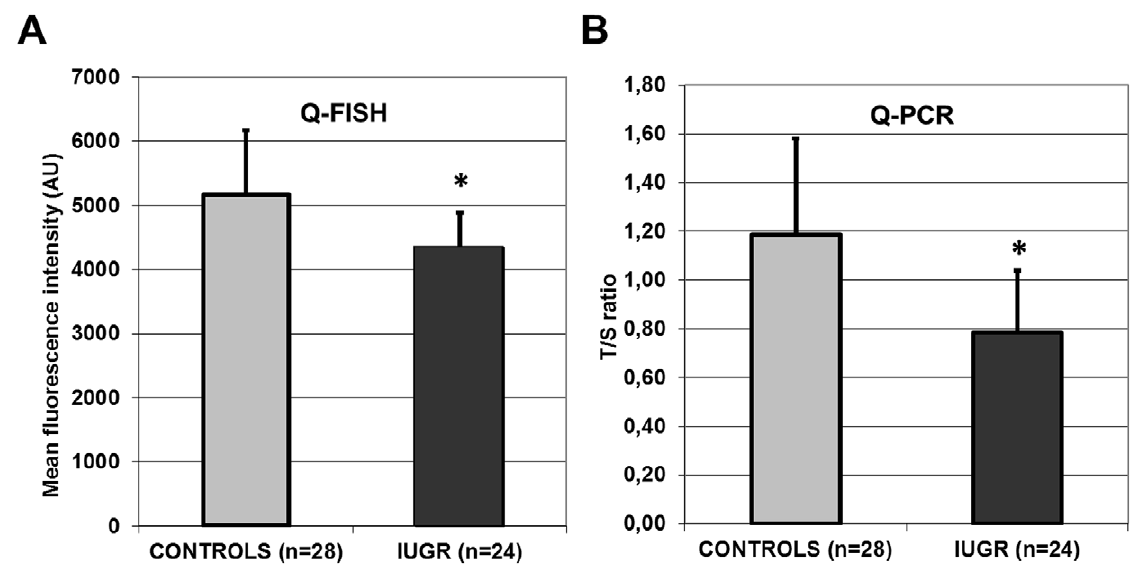
Figure 2. Comparison of placental telomere length between controls and cases with intrauterine growth restriction (IUGR), with two quantitative techniques. A. Quantitative Fluorescence In Situ Hybridization (Q-FISH). Mean placental telomere fluorescence intensity of Peptide Nucleic Acid probes with the Q-FISH technique 6 standard deviation (arbitrary units) for the 28 controls (light grey histogram) and the 24 cases with IUGR (dark grey histogram) (**: p , 0.001, Student’s t-test). B. Quantitative Polymerase Chain Reaction (Q-PCR). Mean placental telomere T/S ratio with the Q-PCR technique 6 standard deviation (no unit) for the 28 controls (light grey histogram) and the 24 cases with IUGR (dark grey histogram) (**: p , 0.001, Student’s t-test).